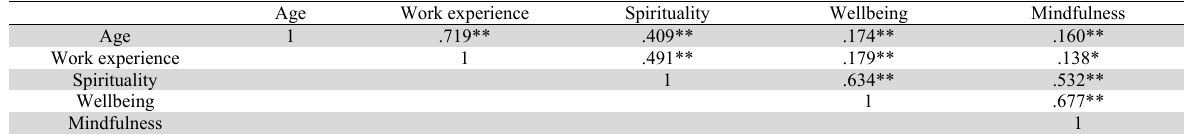
Correlation matrix